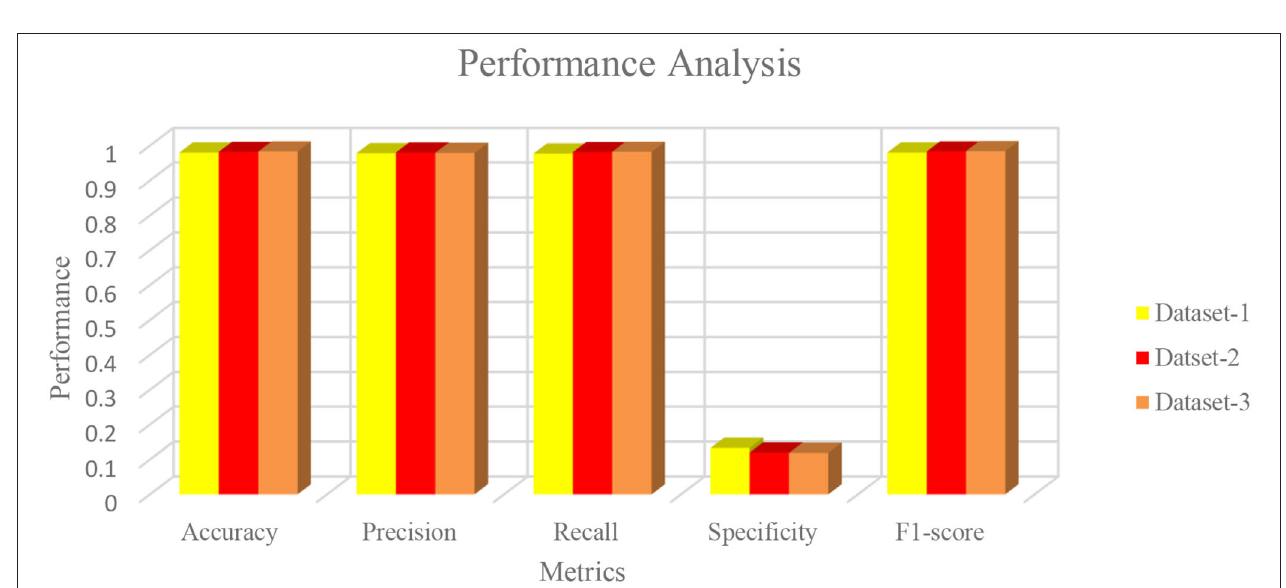
FIGURE 7 | Loss validation curves for the proposed algorithm for different datasets.